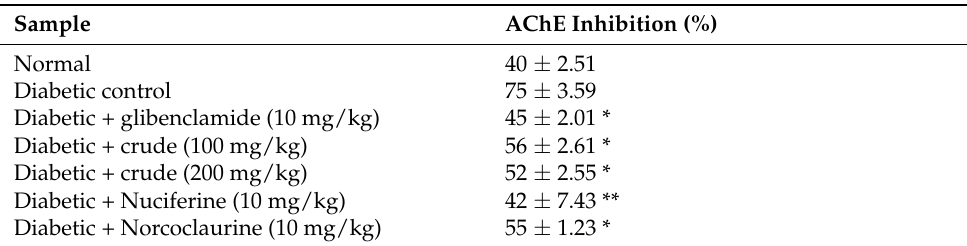
Table 5. Effect of N. nucifera crude, nuciferine and norcoclaurine against AChE activity in blood of diabetic rats ( µ mol AcSCh/h/mg of